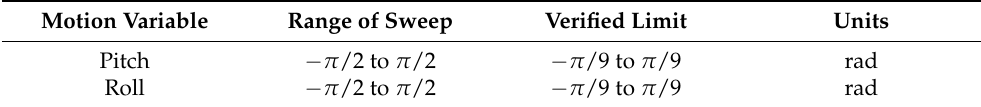
Table 1. Range of motion for the roll and pitch of the end-effector at z = 0.5 m. Motion